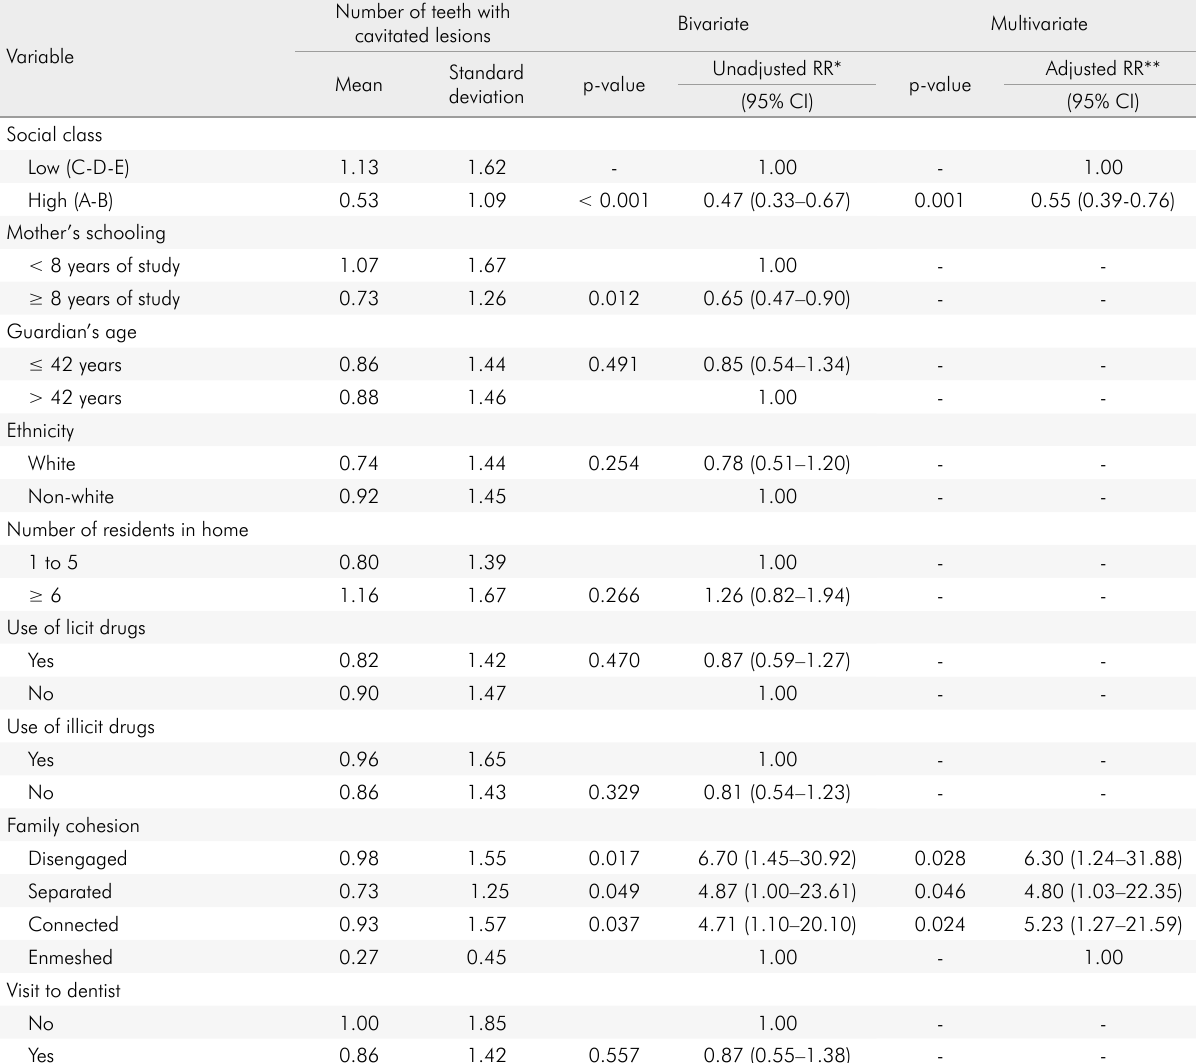
Table 2. Poisson regression for number of cavitated lesions in adolescents, and associated factors.